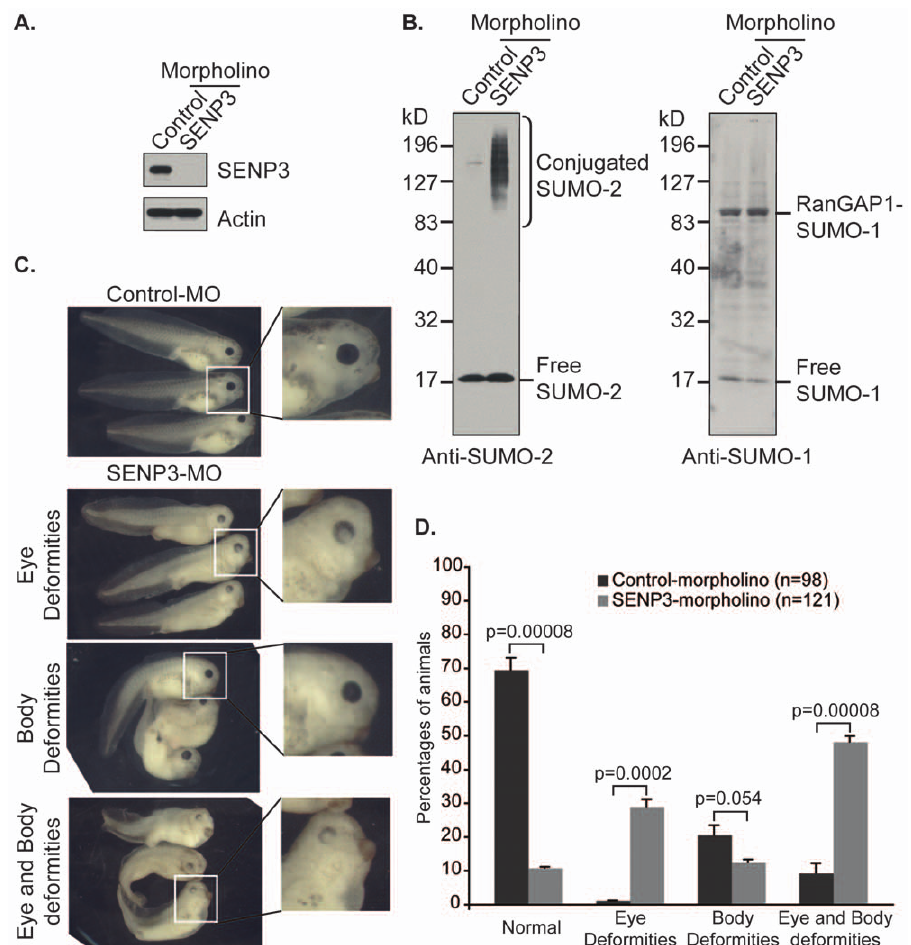
Figure 4. SENP3 is essential for development of Xenopuslaevis embryos. ( A ) One cell embryos were injected with morpholinos, and subsequently harvested at Stage 39. Equal amounts of protein from Control-MO (left) or SENP3-MO (right) embryos were subjected to SDS-PAGE and Western blotting with anti-SENP3 or -actin antibodies. ( B ) Samples as in ( A ) were subjected to SDS-PAGE and Western blotting with anti-SUMO-2 and –SUMO-1 antibodies, as indicated. Note the substantial accumulation of high molecular weight SUMO-2-conjugated species after SENP3 knockdown, while there is essentially no change in SUMO-1 conjugates. ( C ) Morphological defects of SENP3-MO injected embryos were categorized according to defects in body patterning and eye development, as indicated (lower three panels). The morphology of embryos injected with Control-MO is shown in the upper panel. ( D ) Quantitation of morphological body deformities of SENP3-MO injected embryos. Bars indicate standard error of the mean values. p values are